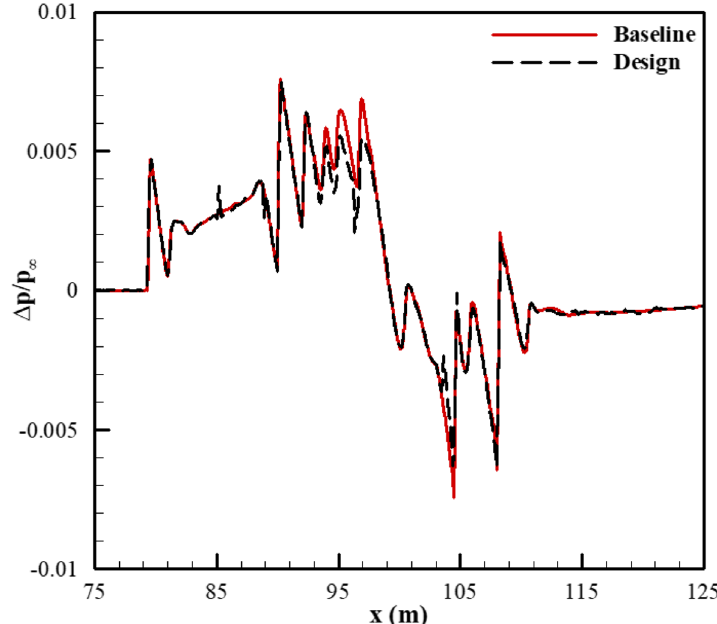
Fig. 17 Comparison of optimized near-field signature and baseline